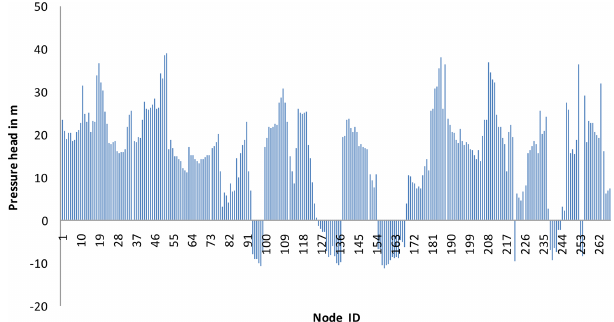
Figure 9. Nodal pressure when reservoir ID 272 is disconnected